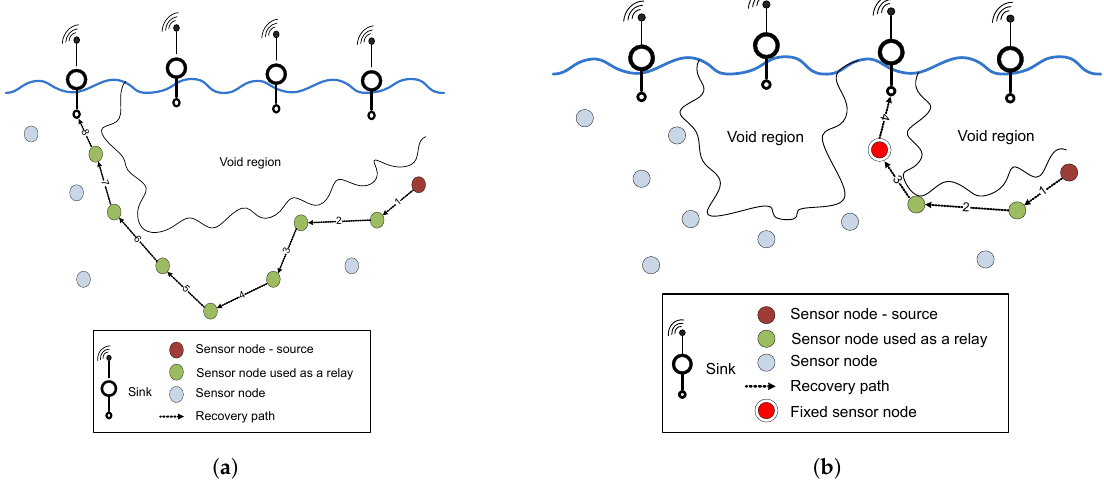
Figure 2. Recovery paths in existing and proposed schemes. ( a ) Long recovery path for data packet delivery; ( b ) Short recovery path due to fixed